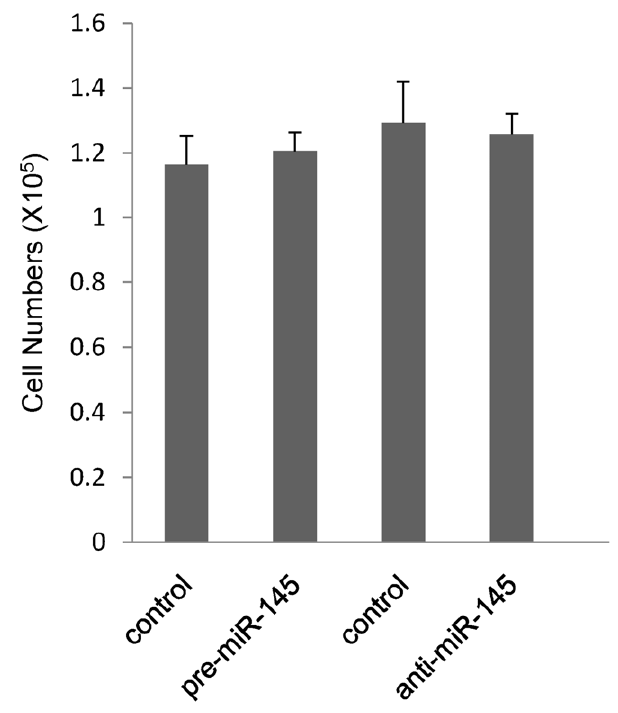
Figure 7. Mir-145 has no influence on proliferation of C3H10T1/2 cells. C3H10T1/2 cells were transfected with pre- miR145, anti-miR-145 or its control, respectively. After 24 h of treatment with TGF- b 3, all of pellets were trypsinized and directly counted in triplicate using a hemacytometer. Data was represented as mean 6 sd.